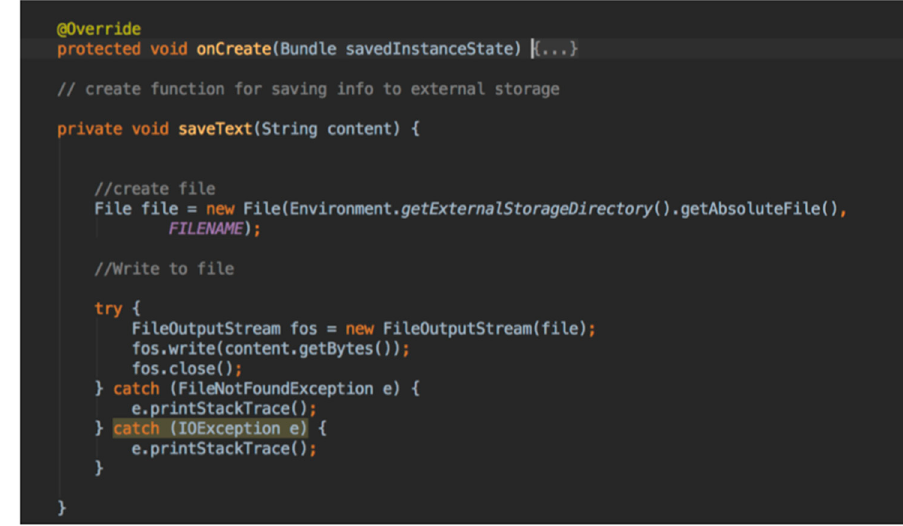
Figure 9. Method for saving to a txt file within device’s internal storage of the number of times “Back” button was clicked.